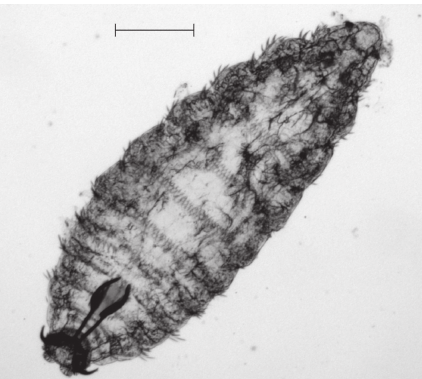
Figure 1: O. ovis L1 collected from the dog after nasal lavage (40x). Black bar indicates 200 𝜇 m length.